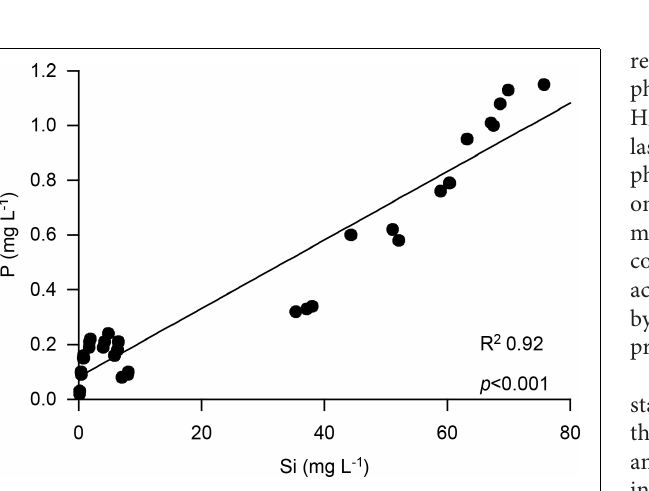
FIGURE 4 | Mobilization of P and Si from soil with different ASi content collected from a mobilization experiment.